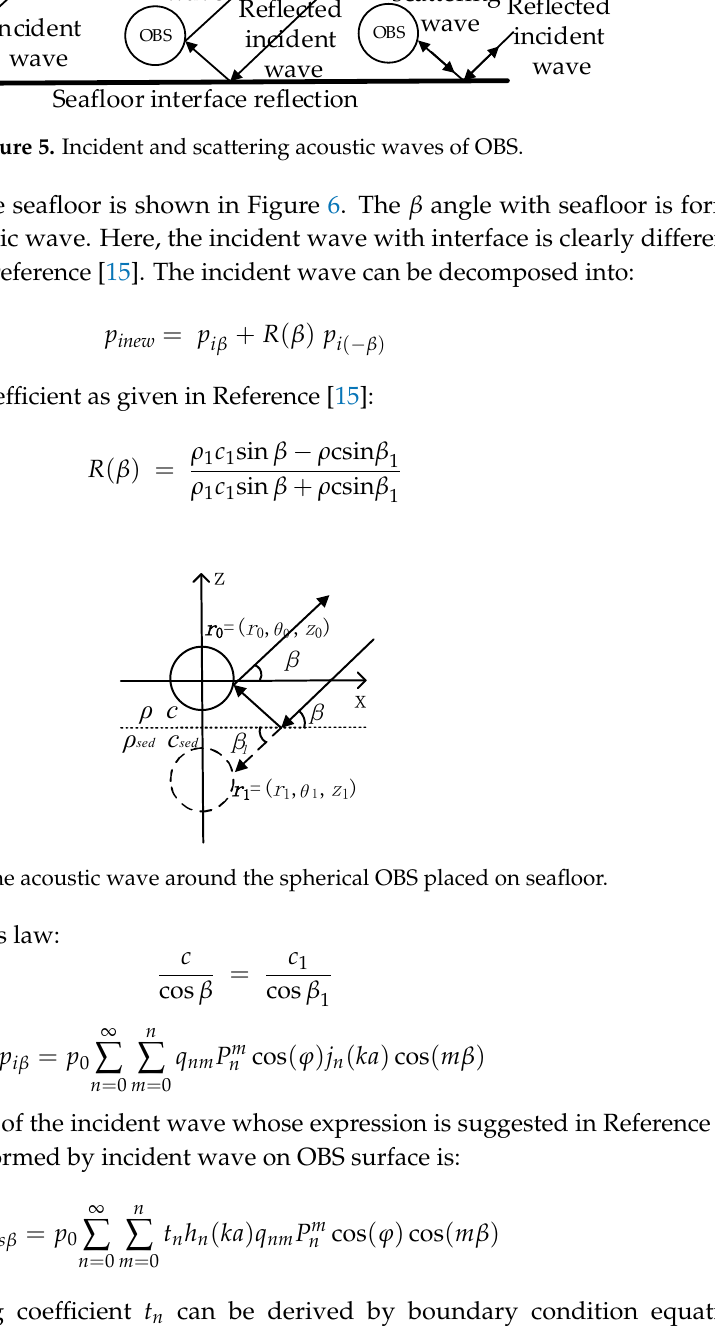
Figure 6. The acoustic wave around the spherical OBS placed on seafloor.